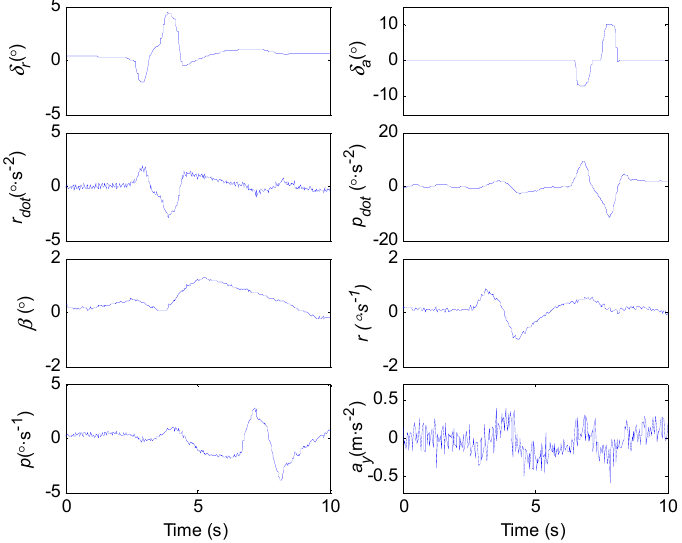
Figure 13. Flight test data of response of combined rudder and aileron doublet input for MLE identification. Table 3. Identification results of aerodynamic